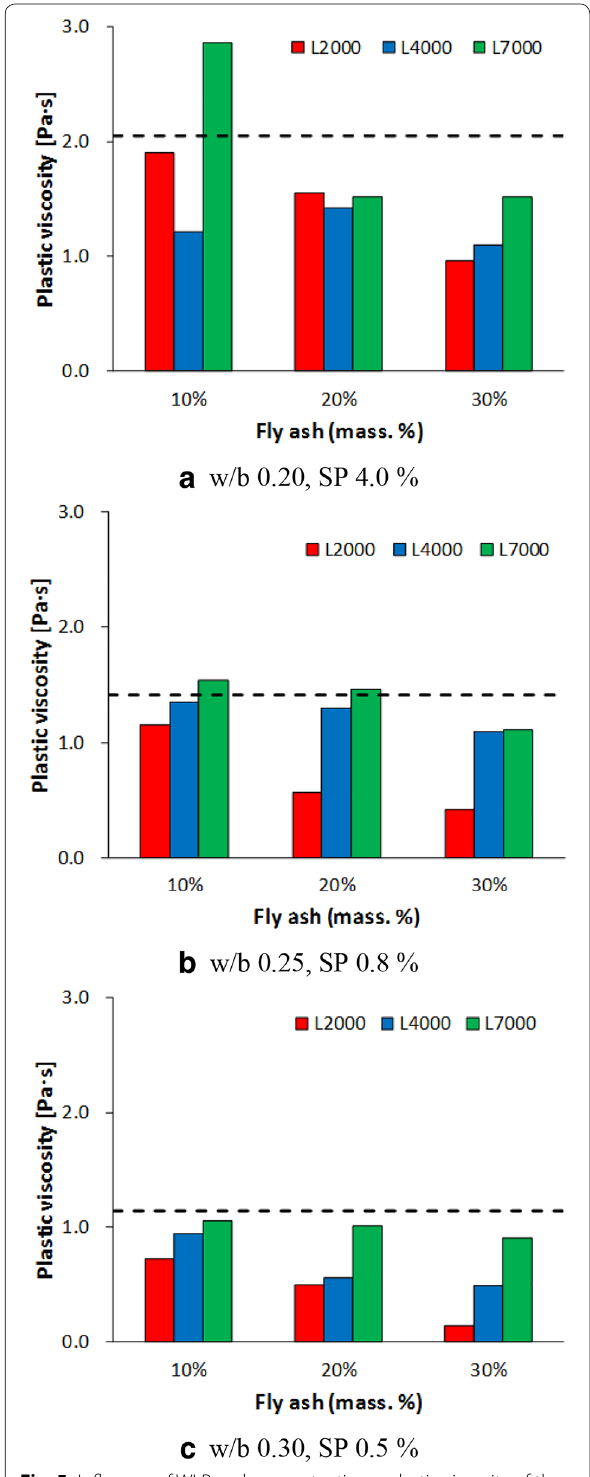
Fig. 5 Influence of WLP replacement ratio on plastic viscosity of the pastes depending on different WLP fineness.